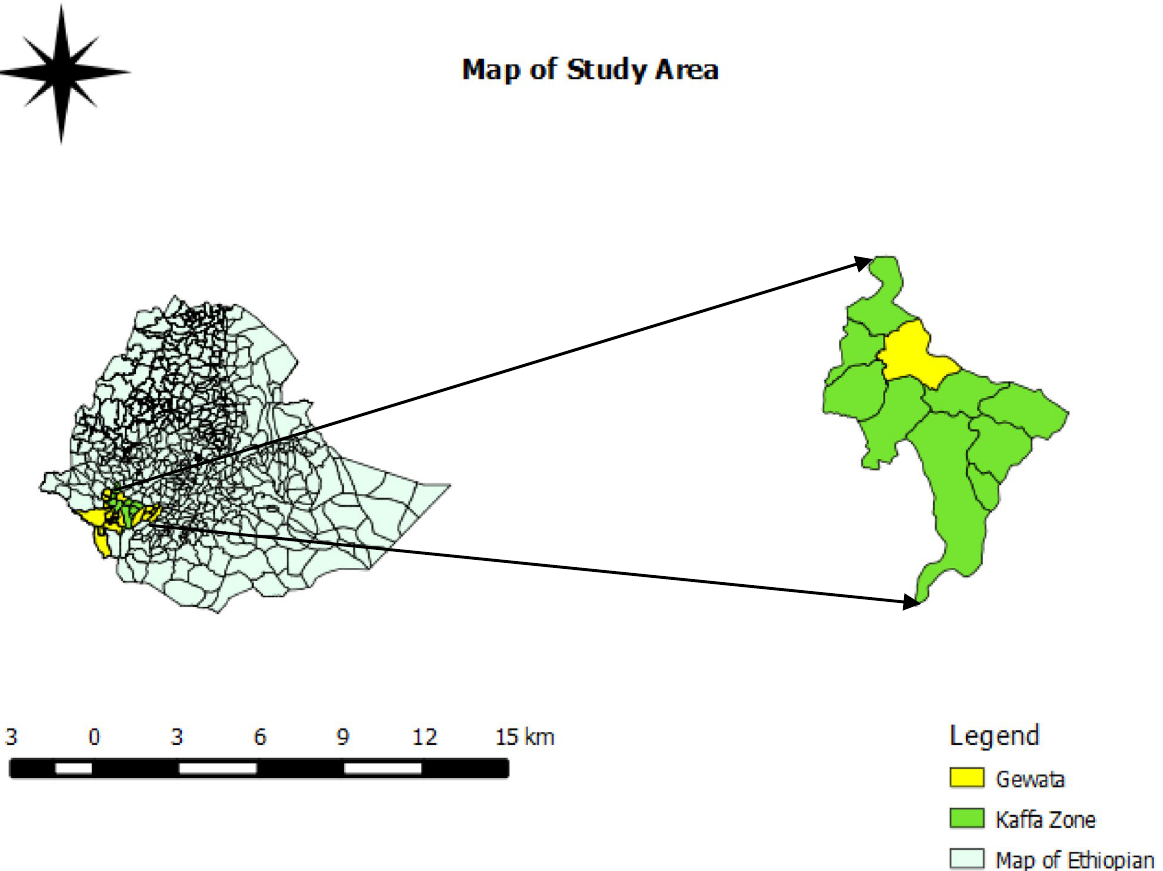
Fig. 3 Map of Gewata district, Arc GIS,